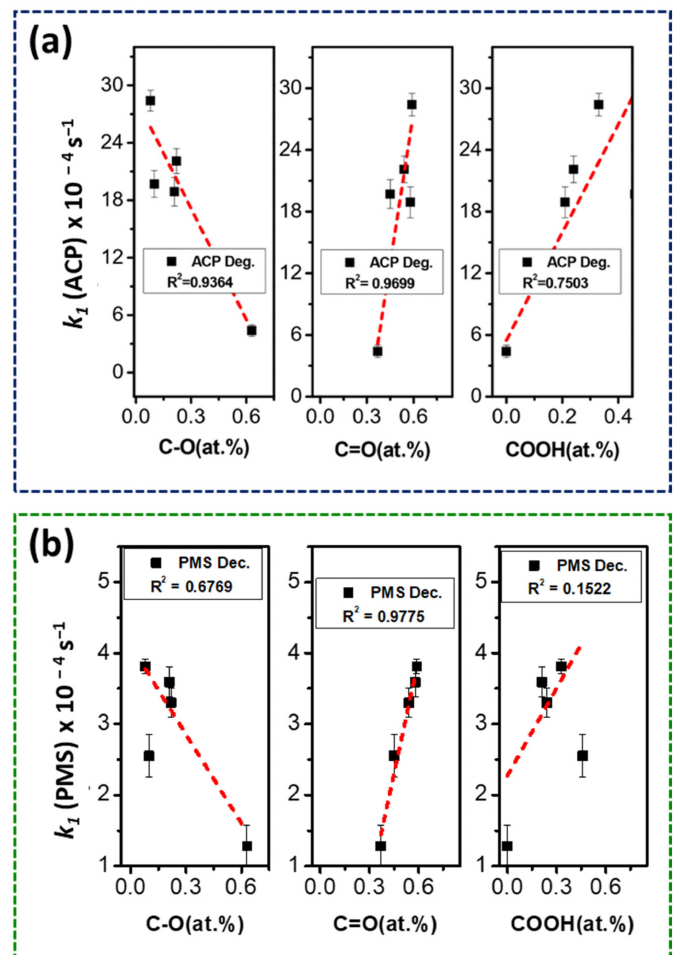
Figure 3. Role of O-contents and oxygen functionalities in k 1 (ACP) ( a ), and k 1 (PMS) ( b ). Experimen- tal conditions C ACP = 10 mg L − 1 , C Catalyst = 100 mg L − 1 , C PMS = 0.5 mM and pH 0 = 7 ±